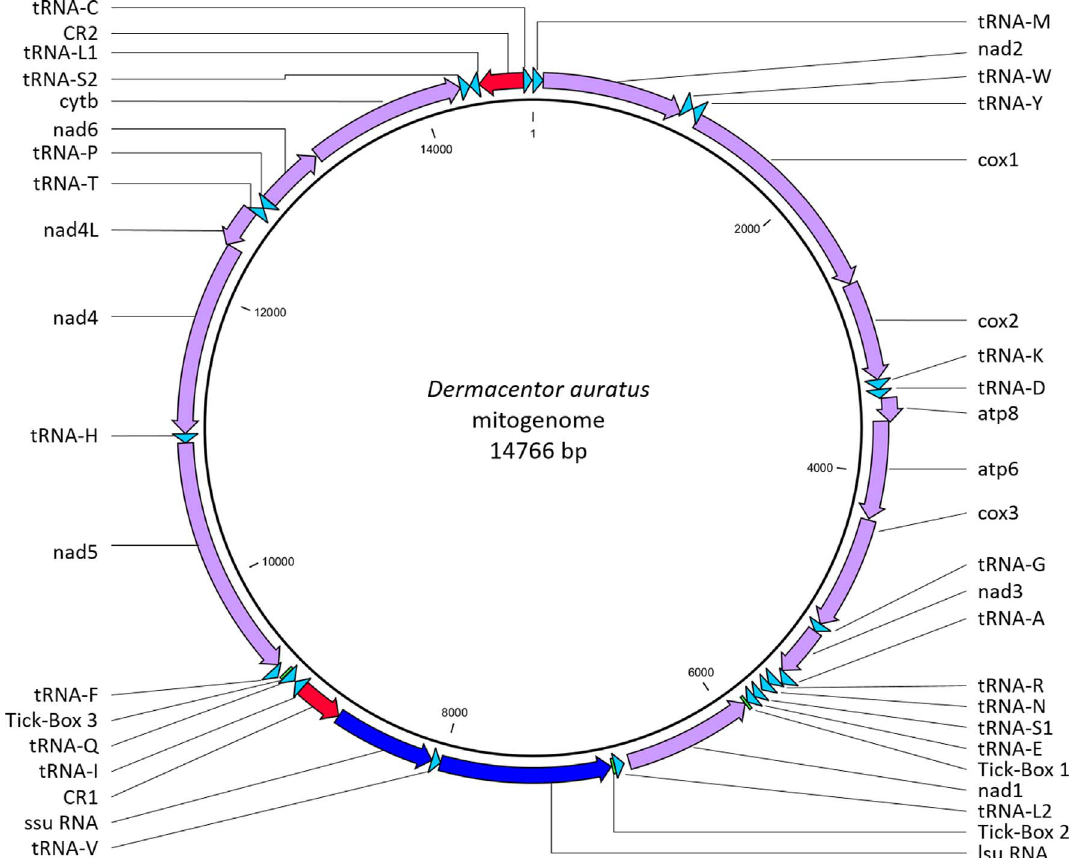
Figure 1. Map of the mitochondrial genome of Dermacentor ( Indocentor ) auratus . Protein coding genes in purple; ribosomal RNA genes in dark blue; transfer RNA genes in light blue; control regions in red, and tick-boxes in